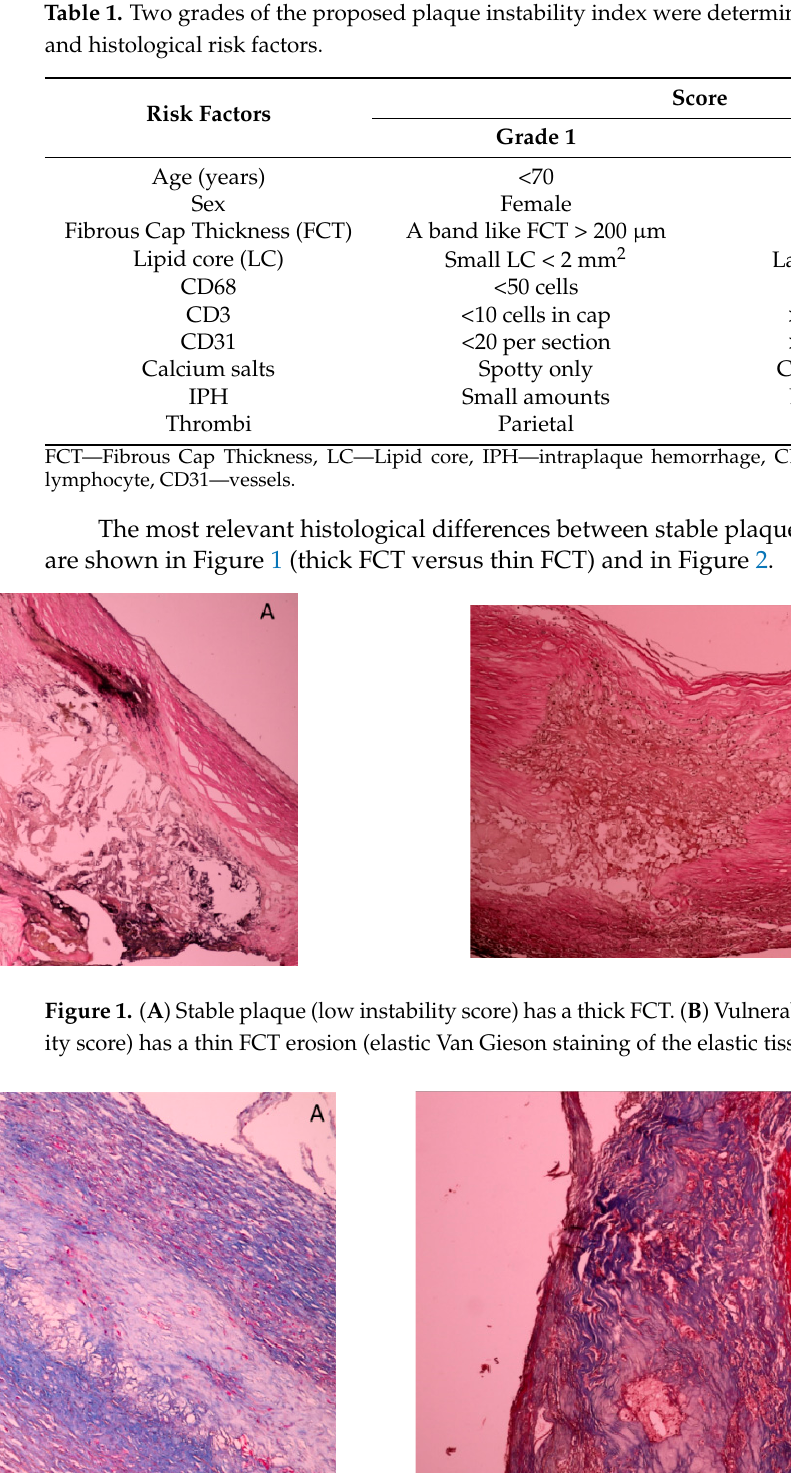
Table 1. Two grades of the proposed plaque instability index were determined by assessing clinical and histological risk factors.